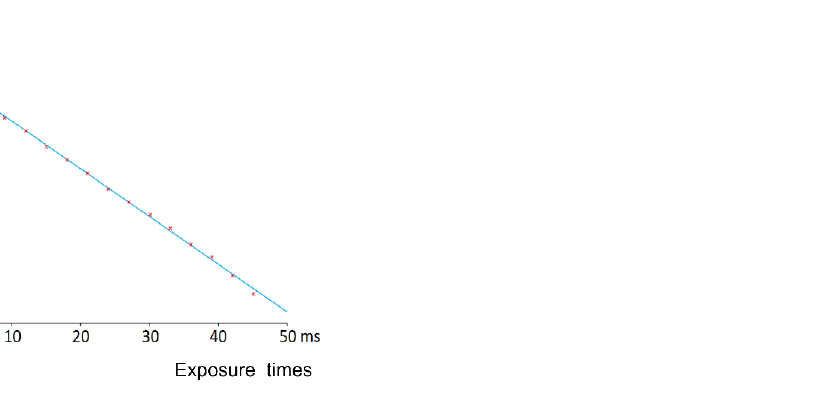
Figure 6. Proof of the linear relation between the exposure time and the constant grey level subtracted from the acquired image to get the enhanced one.